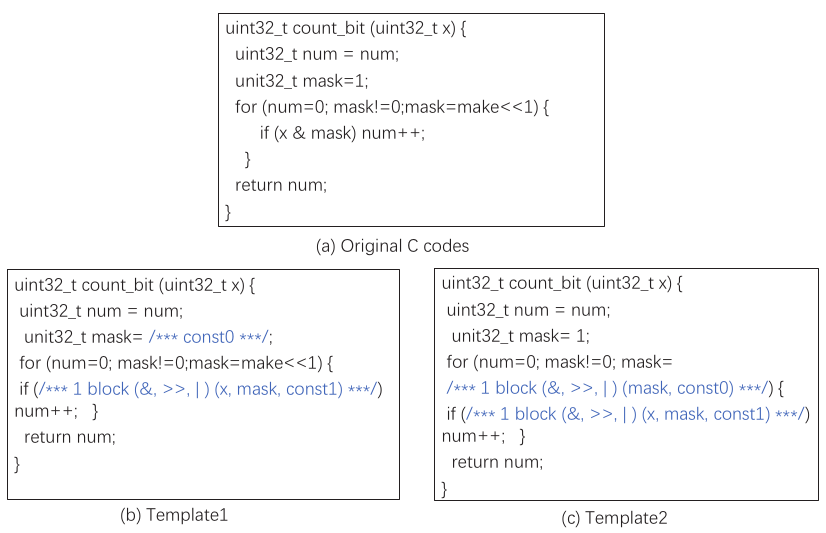
Figure 12. Original C code for counting 1’s and two